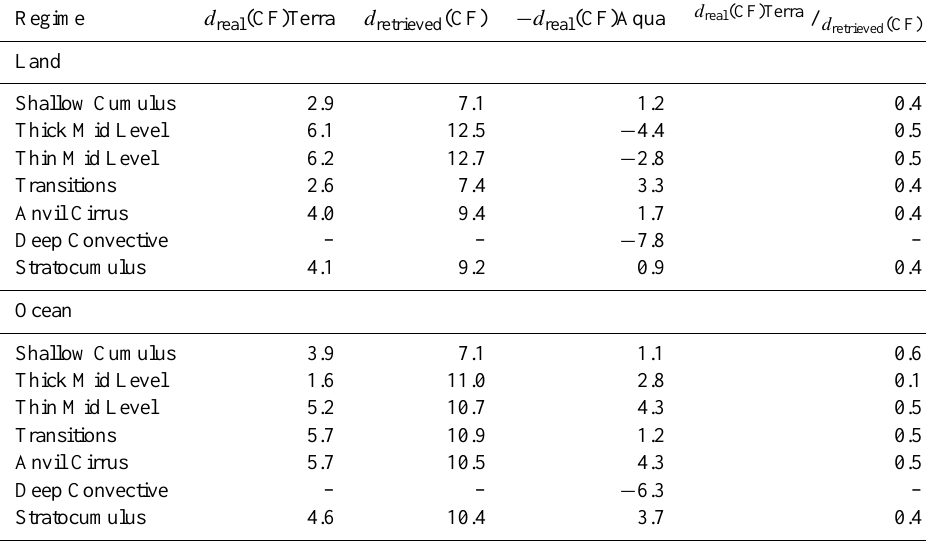
Table 2. Difference in cloud fraction between high and low AI populations at the end of the timestep (Eq. 1). d real (CF)Terra uses an AI retrieval from the start of the timestep to determine a non-cloud contaminated AI, whereas d retrieved (CF) uses a contaminated retrieval performed at the end of the timestep. Both d real (CF)Terra and d retrieved (CF) use the same population of clouds. − d real (CF)Aqua is determined using an AI retrieval at the end of the timestep, and uses a different population of clouds, so it is not exactly comparable. It is presented as a negative due to the AI being retrieved at the end of the timestep, and so d real (CF)Aqua is determined “backwards” in time compared to the other measurements of d